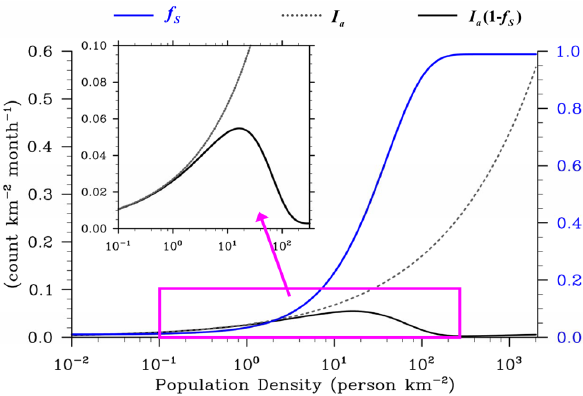
Fig. 4. Fraction of fires suppressed by humans f s (blue solid), total anthropogenic ignitions I a (countkm − 2 month − 1 ; gray dash), and unsuppressed anthropogenic ignitions I a ( 1 − f s ) (countkm − 2 month − 1 ; black solid) as functions of population den- sity.